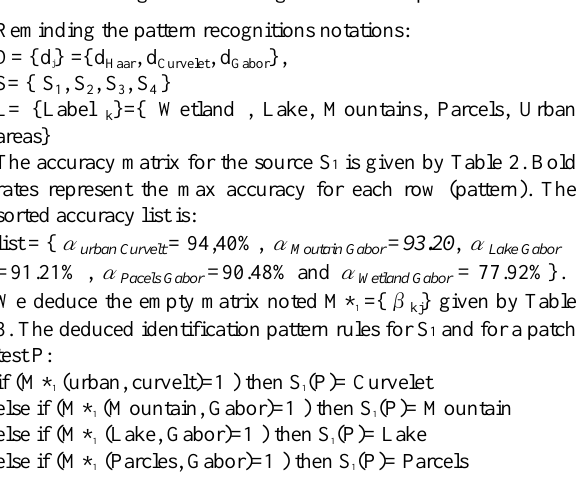
Figure 8. Learning data base